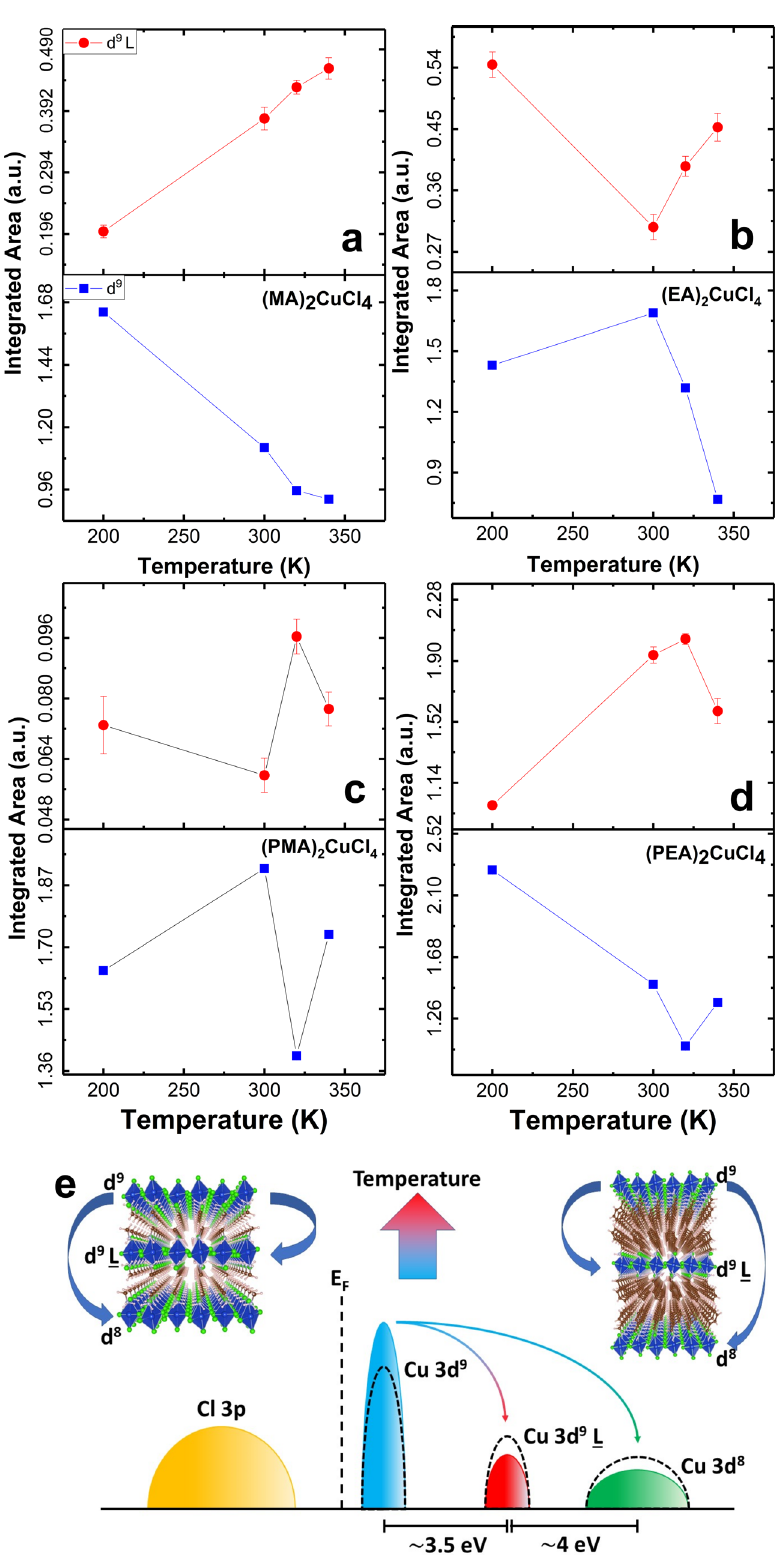
Fig. 3 The overview of integrated area acquired from the XAS spectra of A 2 CuCl 4 compounds. The evolution of d 9 L (red circles) and d 9 (blue circles) of Schematic representation of spectral weight transfer of the short and long ligand spacers compounds. The arrows indicate the respective electronic